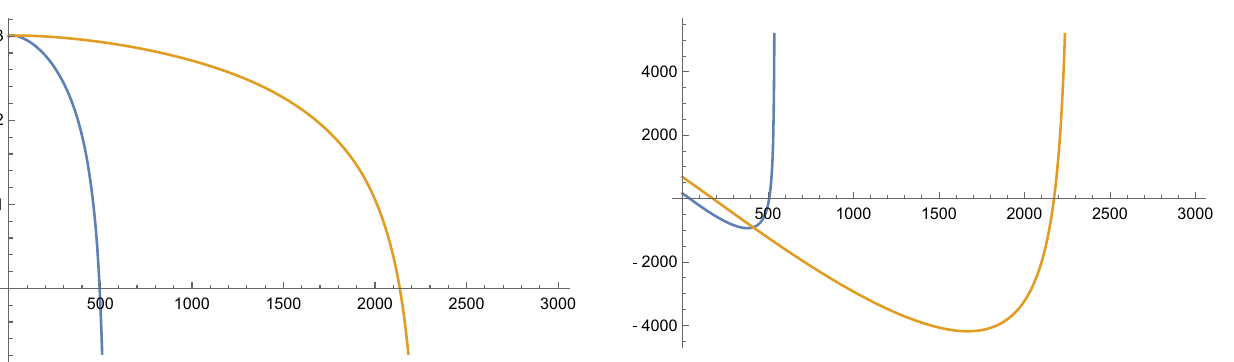
Fig. 10 Entropy of Tsallis statistics in terms of temperature with G = m = k = 1, and λ = 1 / 6. The blue line corresponds to N = 10 and the brown one to N = 15 The allowed physical temperatures are those for which S > 0